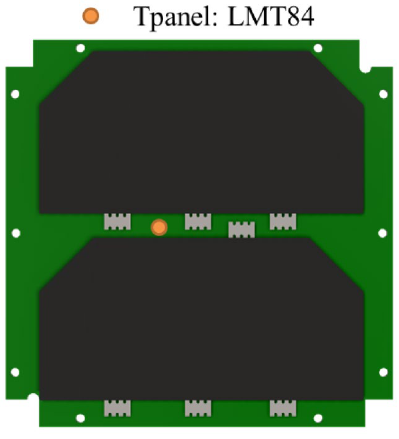
Figure 2. Solar panel with two cells connected in series.